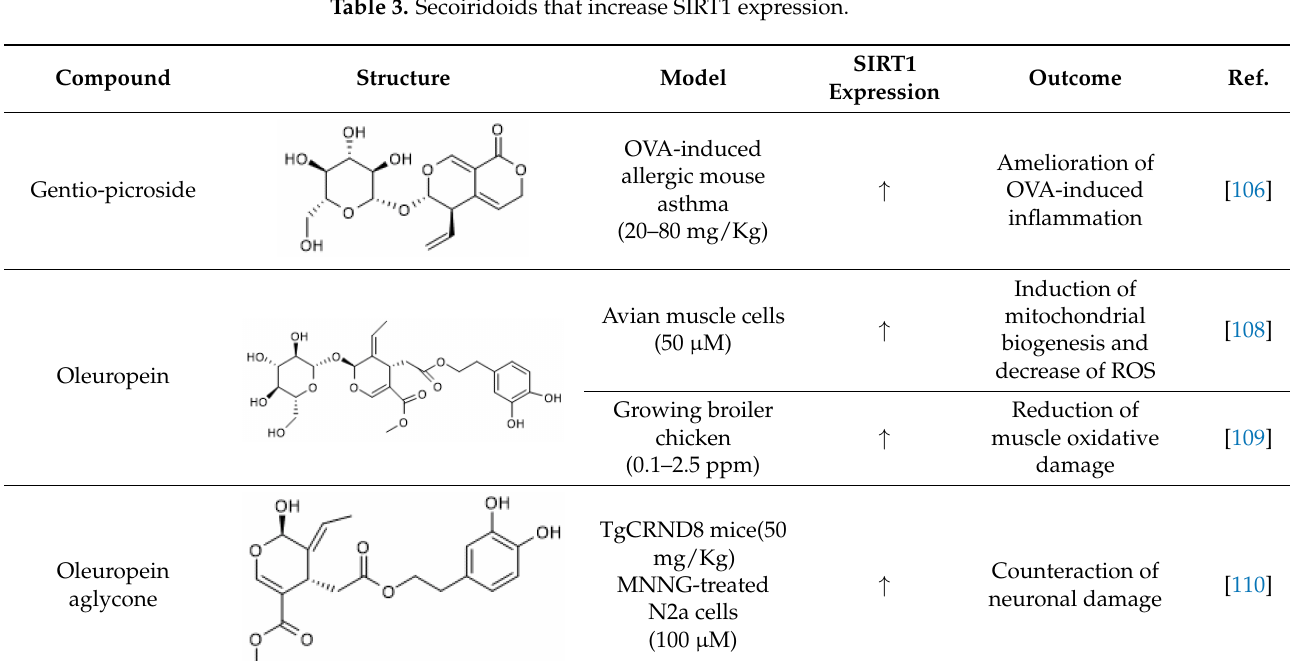
Table 3. Secoiridoids that increase SIRT1